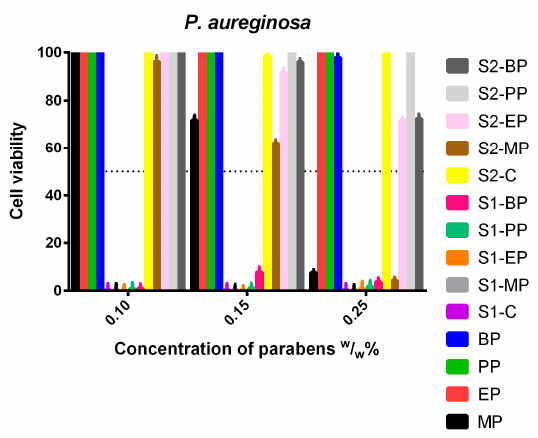
Figure 13. Cell viability of P. aeruginosa against the control paraben solutions (MP; EP; PP; BP); the first system (S1-MP; S1-EP; S1-PP; S1-BP) and the second system (S2-MP; S2-EP; S2-PP; S2-BP). Cell viability expressed as the percentage of the absorbance of the untreated control. Data expressed as mean ±